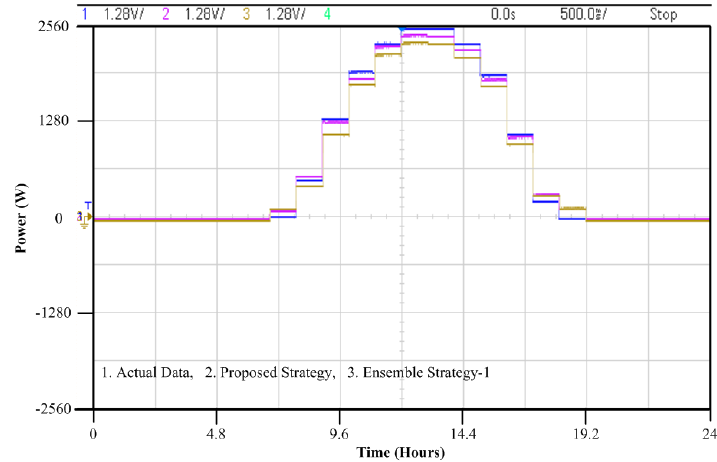
Figure 6. Forecasting result of PV power with proposed ensemble strategy and ensemble strategy-1.